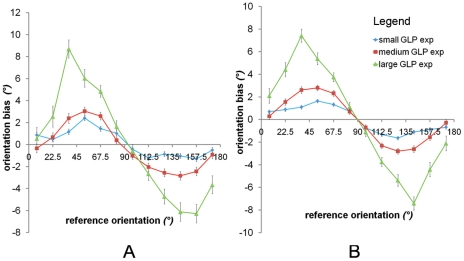
The results from the psychophysical experiment.A) showing average orientation biases (the vertical axis) for all twelve reference orientations of the GLPs (horizontal axis) and each thickness of the GLPs (colors, see legend). The bias is denoted as the difference between the perceived orientation and the real orientation of the administered GLP. B) A regularized version of the data less vulnerable to overfitting is shown. The bias magnitudes are averaged over pairs of orientations under the assumption that the bias magnitudes should be equal for the mirrored GLPs over the vertical axis. Error bars denote SEMs.